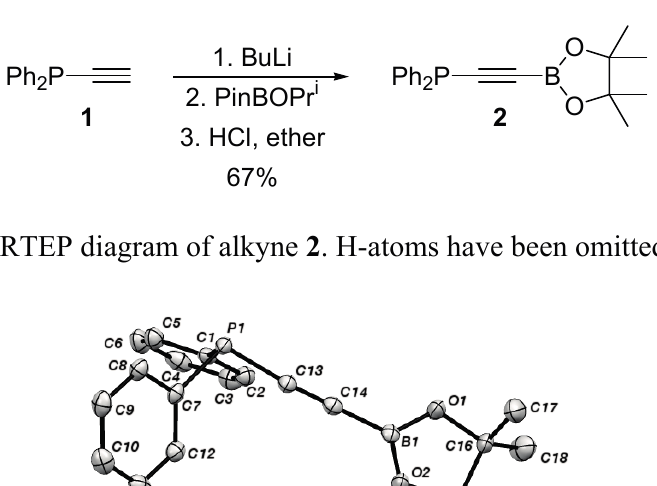
Scheme 1. Synthesis of a phosphine substituted alkynylboronate.